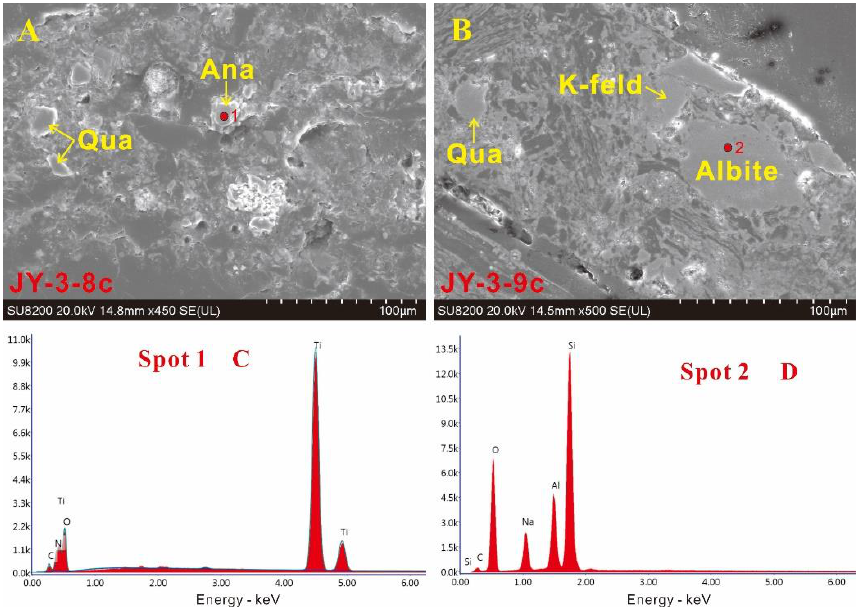
Figure 9. SEM secondary electronic images of anatase (Ana), K-feldspars (K-feld) and albite in the JY-3 Coal. ( A , B ), detrital anatase and feldspars; ( C , D ) are EDS spectrums of respective test spots in ( A , B ).